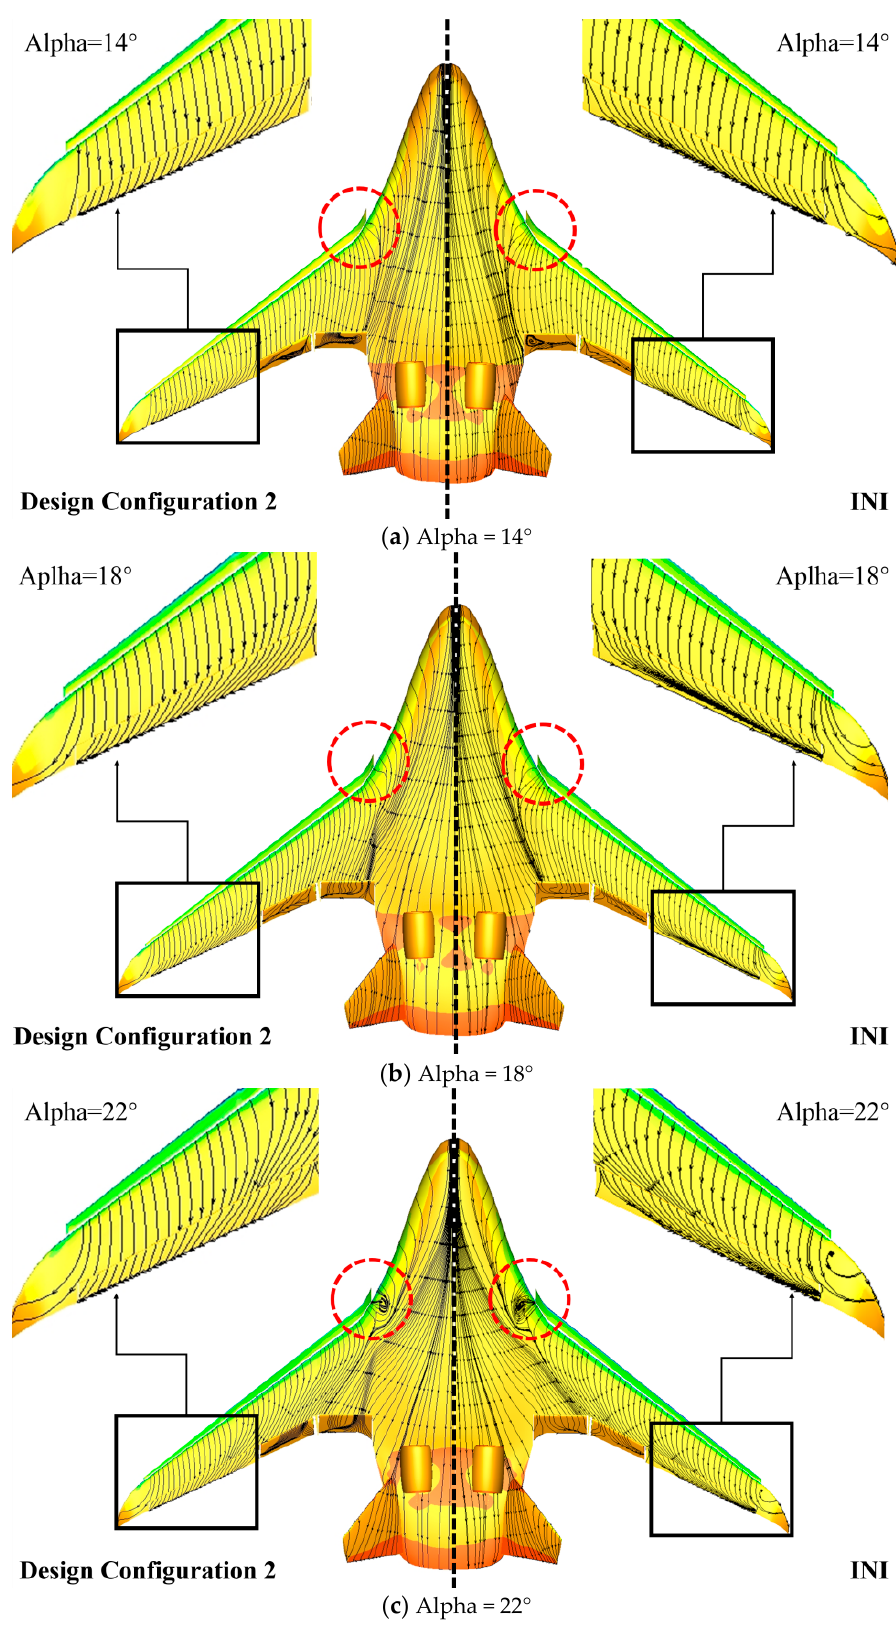
Figure 24. Surface limiting streamlines of INI and Design Configuration 2. At Alpha from − 4°to 16°, the di ff erence of the lift curves shown in Figure 25a between INI and Design Configuration 2 is very small, and they all increase linearly. When the